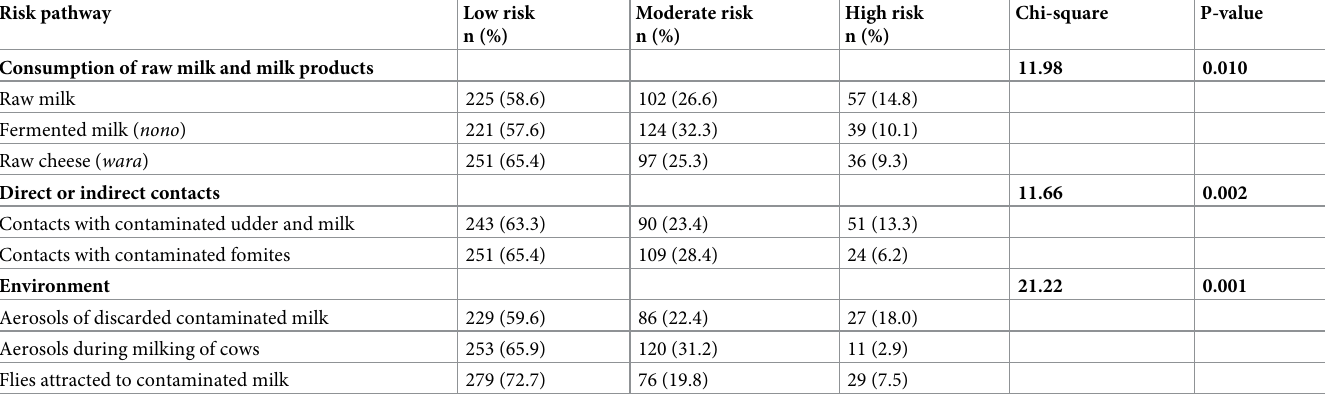
Moderate risk High risk Chi-square P-value n (%) n (%) n (%)